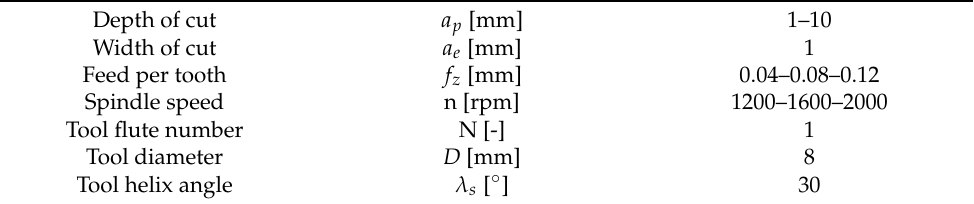
Table 3. Machining parameters during the experimental